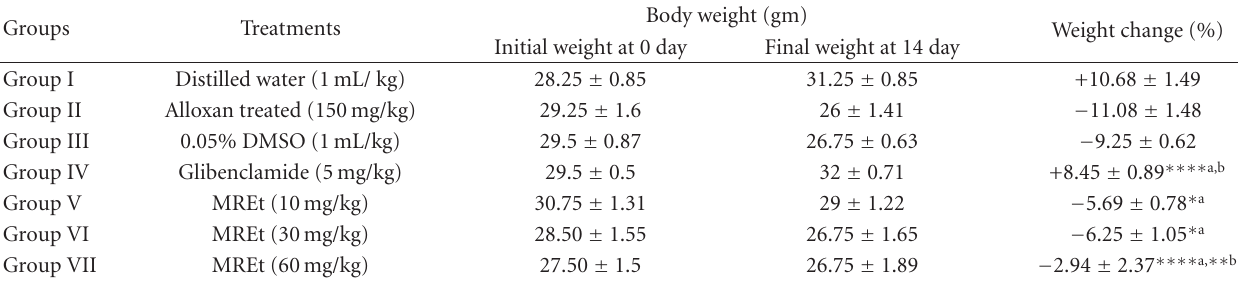
Table 2: E ff ect of MREt of R. serpentina on body weights of mice.